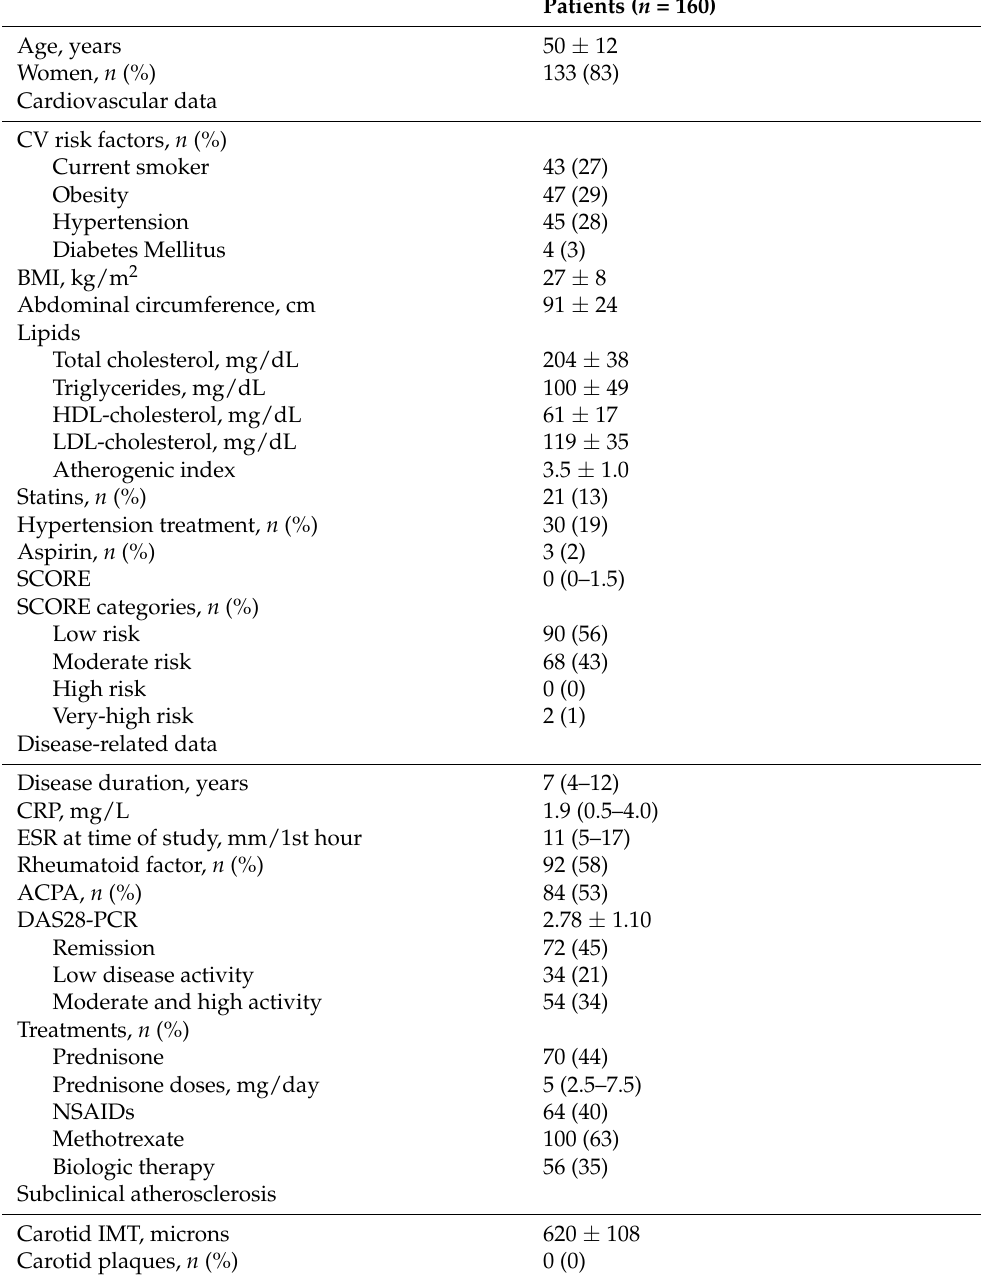
Table 1. Demographics, cardiovascular risk factors, and disease-related data in rheumatoid arthritis patients at